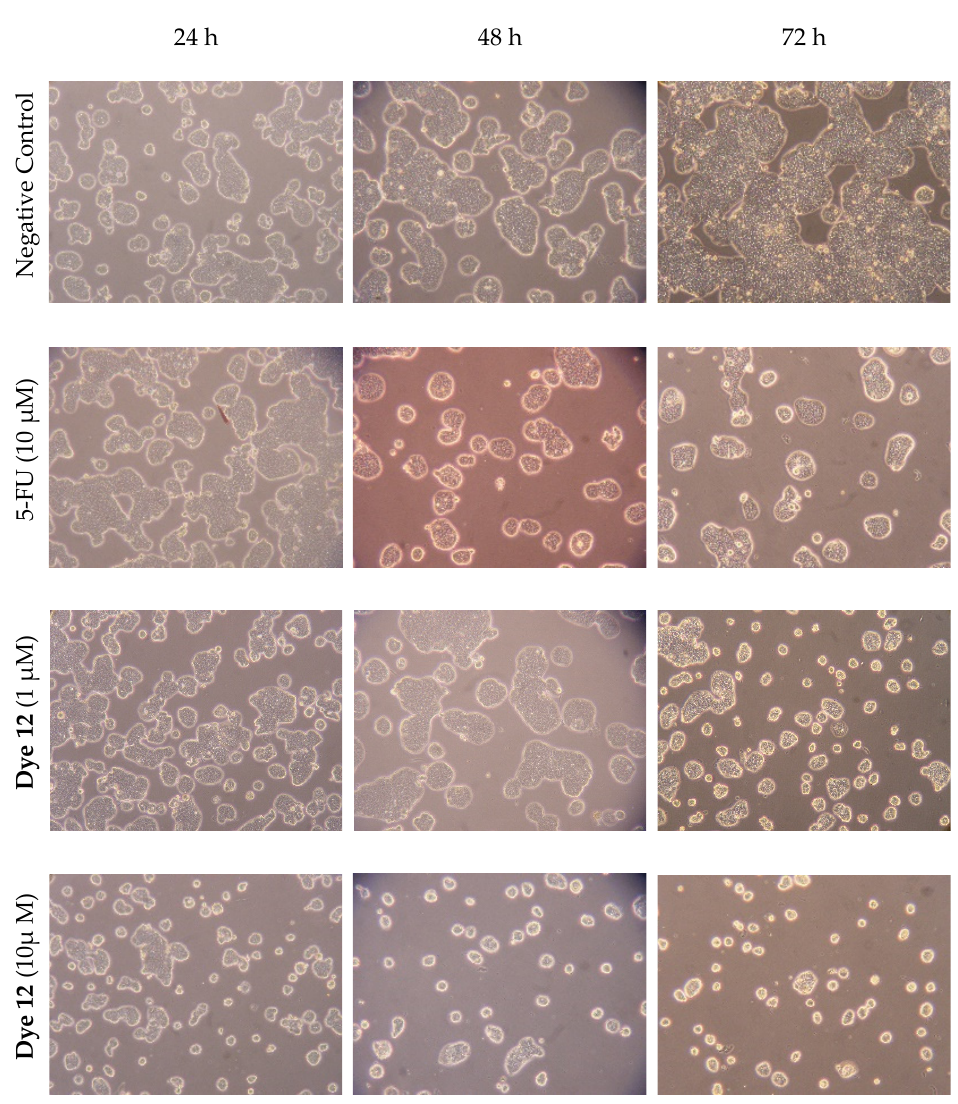
Figure 5. Microscopic images of Caco-2 cells treated in the dark with monomethine cyanine dye 12 at the concentrations of 1 and 10 µM and 5-FU at the concentration of 10 µM. Images were recorded at 10× magnification after 24, 48, and 72 h of incubation with the tested compounds.